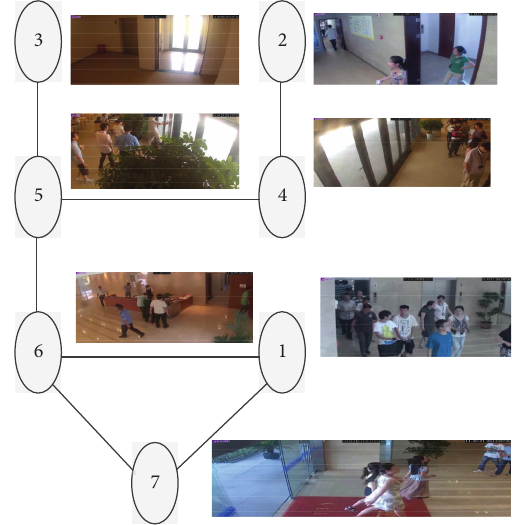
Figure 1: Camera topology